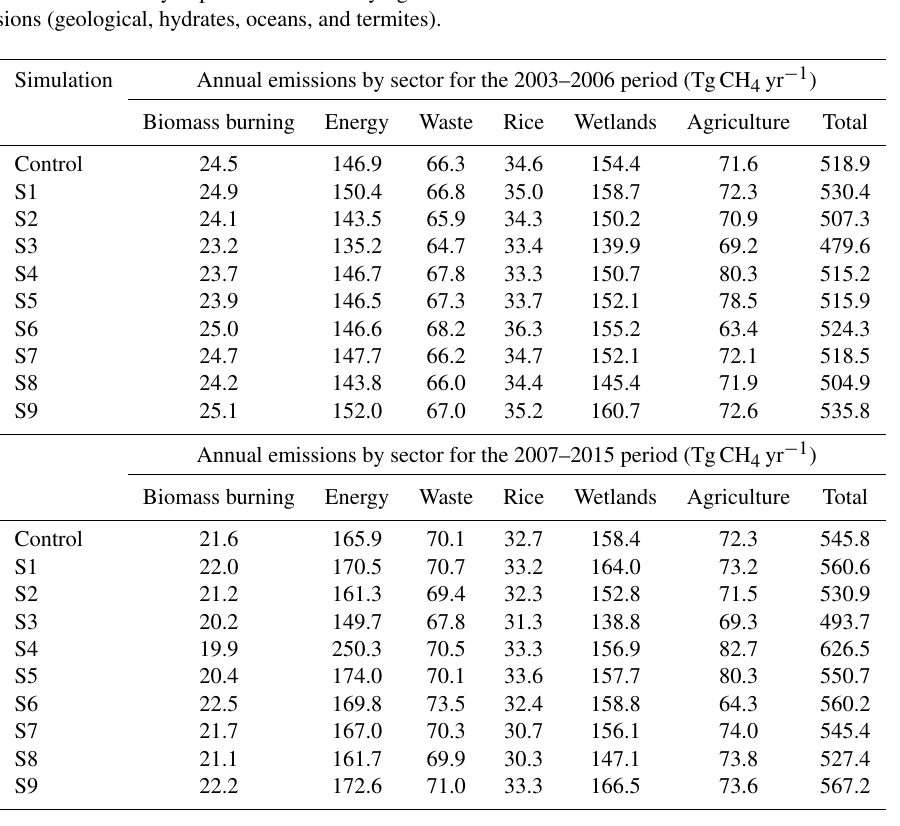
Table 8. Posterior annual CH 4 emissions for the period of near-zero atmospheric growth (2003–2006) and the renewed growth (2007–2015) based on a suite of inversion sensitivity experiments with varying errors on source and sink estimates. Note the total emissions include the supplementary emissions (geological, hydrates, oceans, and